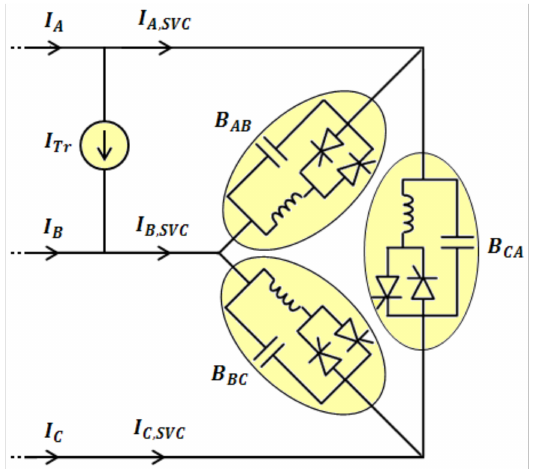
Figure 5. SVC and single train